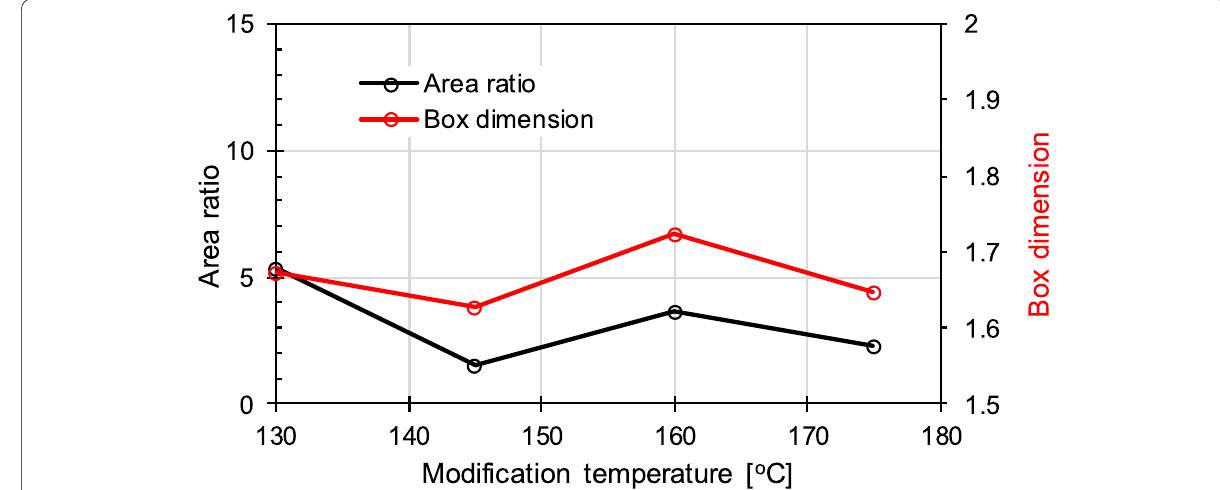
Fig. 10 Influence of modification temperature on the area ratio and box dimension in mix